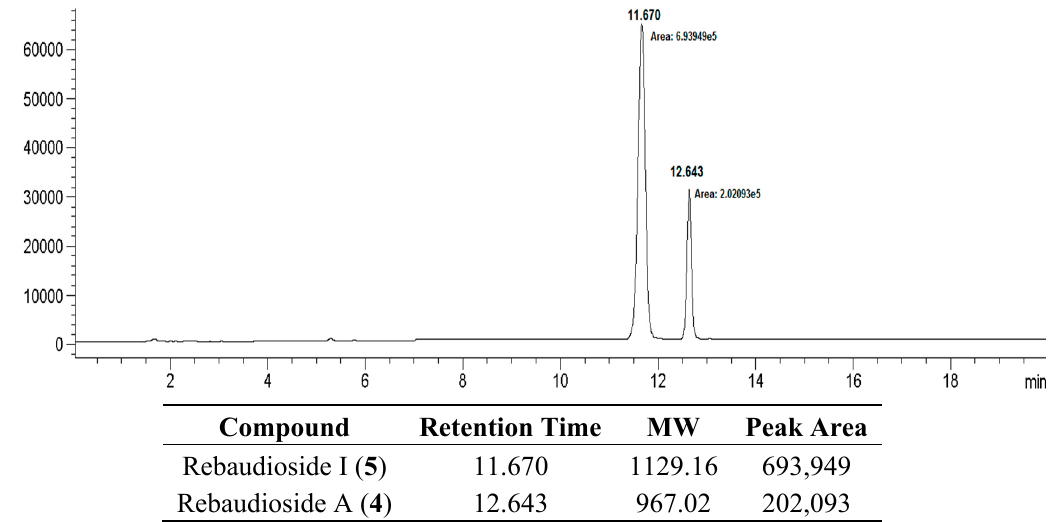
Compound Retention